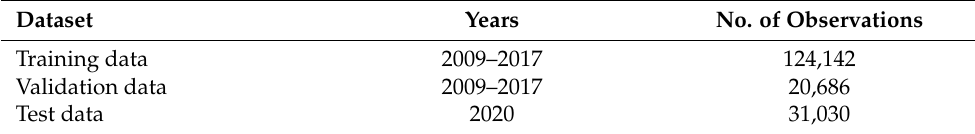
Table 1. The total number of observations in datasets used in this paper.